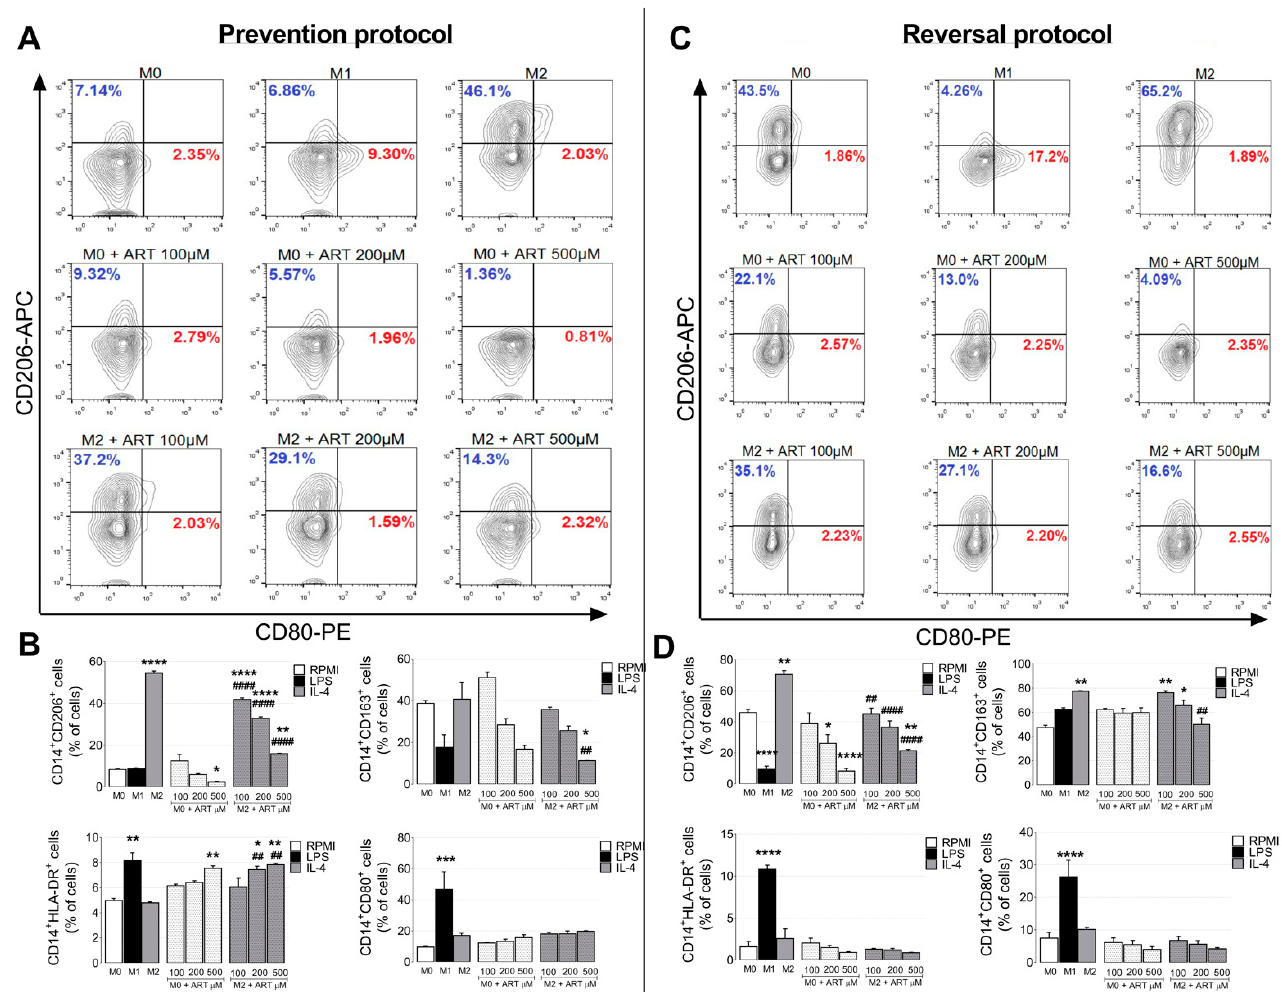
Figure 3. ART treatment induces phenotypic changes of human primary monocytes. Monocytes were treated with increased doses of ART (100, 200, and, 500 µ M) for 24 h in the prevention protocol in the presence or not of IL-4 ( A , B ). In the reversal protocol ( C , D ), cells were treated with IL-4 for 6 h and ART was then added in fresh medium for an additional 18 h. Phenotypic markers for M1- and M2-like monocytes (CD80, CD206, CD163, and HLA-DR) were analyzed by flow cytometry. Populations were gated for CD14 positive cells. Red percentages represent CD80 positive cells and blue percentages CD206 positive cells. Data represent mean ± SEM of at least three independent experiments performed in triplicate. Data were analyzed by ANOVA followed by Tukey post hoc. *, **, ***, and ****, significantly different from control M0 cells (white bar). ## and ####, significantly different from M2 cells (grey bar). M0: Naive control monocytes maintained in RPMI 10%, M1: positive control for inflammatory monocytes maintained in LPS and, M2: immunosuppressive monocytes maintained in IL-4.